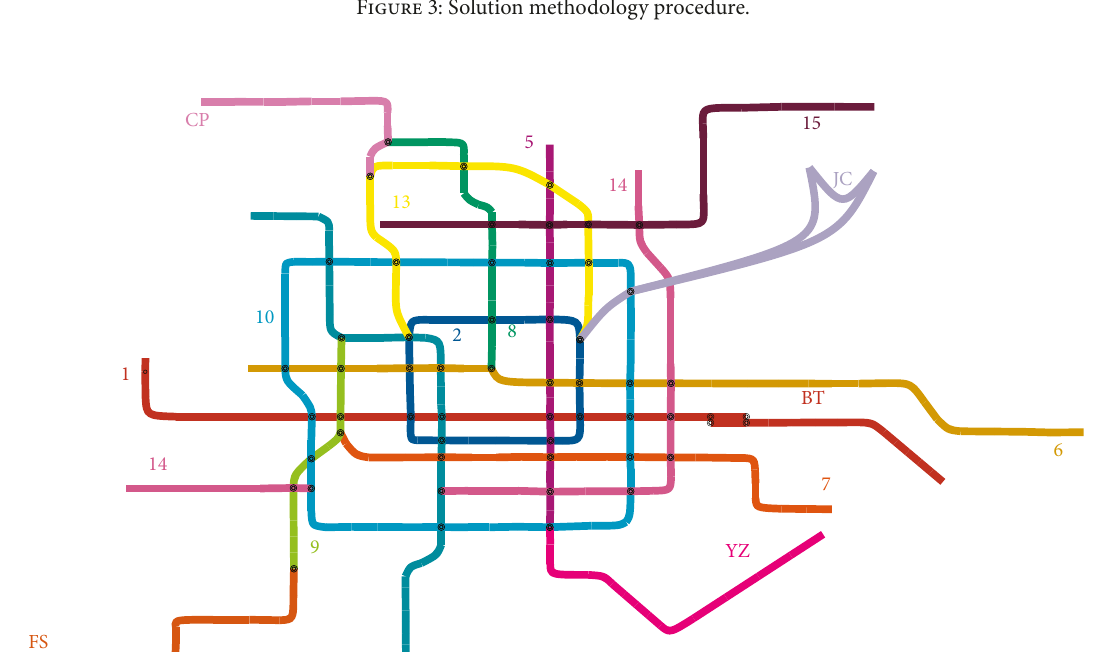
Figure 3: Solution methodology procedure.